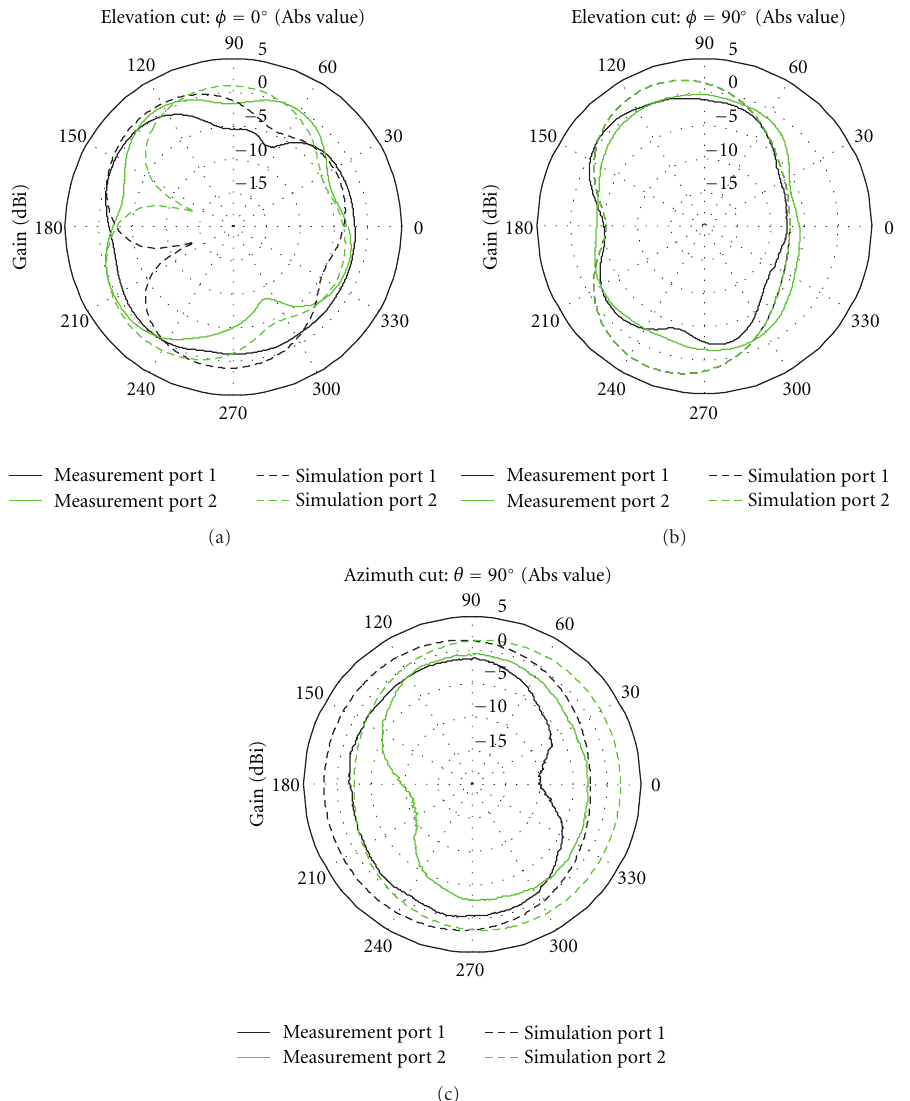
Figure 8: Radiation pattern cuts of the MIMO antenna system #1 (measurements versus